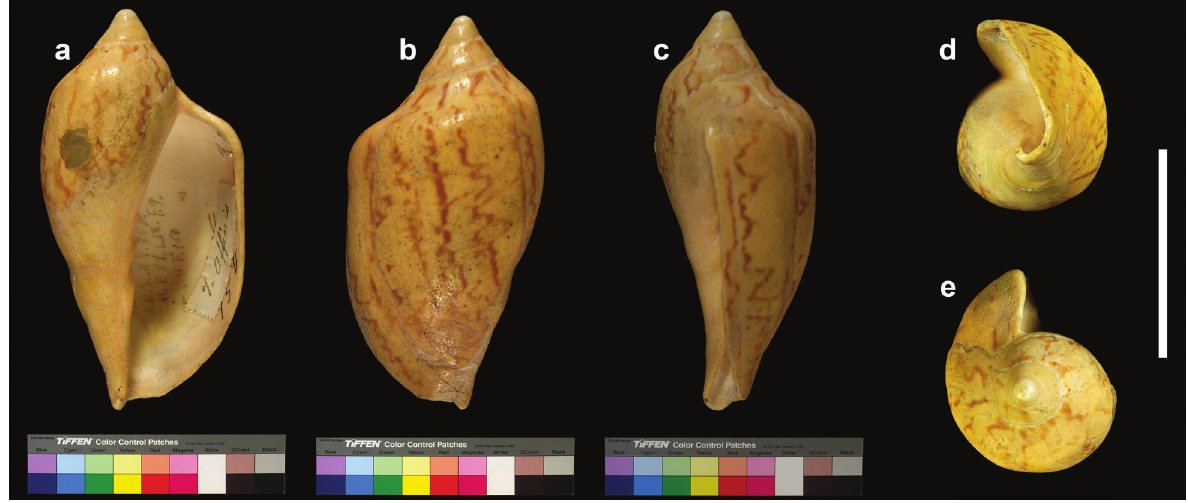
Figure 16. Voluta angulata affinis , specimen figured by Lahille (1895: pl. II, fig. 75b; pl. VI, fig. 91; pl. IX, fig. 9; pl. VIII, fig. 160). a Apertural view b Dorsal view c Lateral view d Umbilical view e Apical view. Scale bar: 5 cm